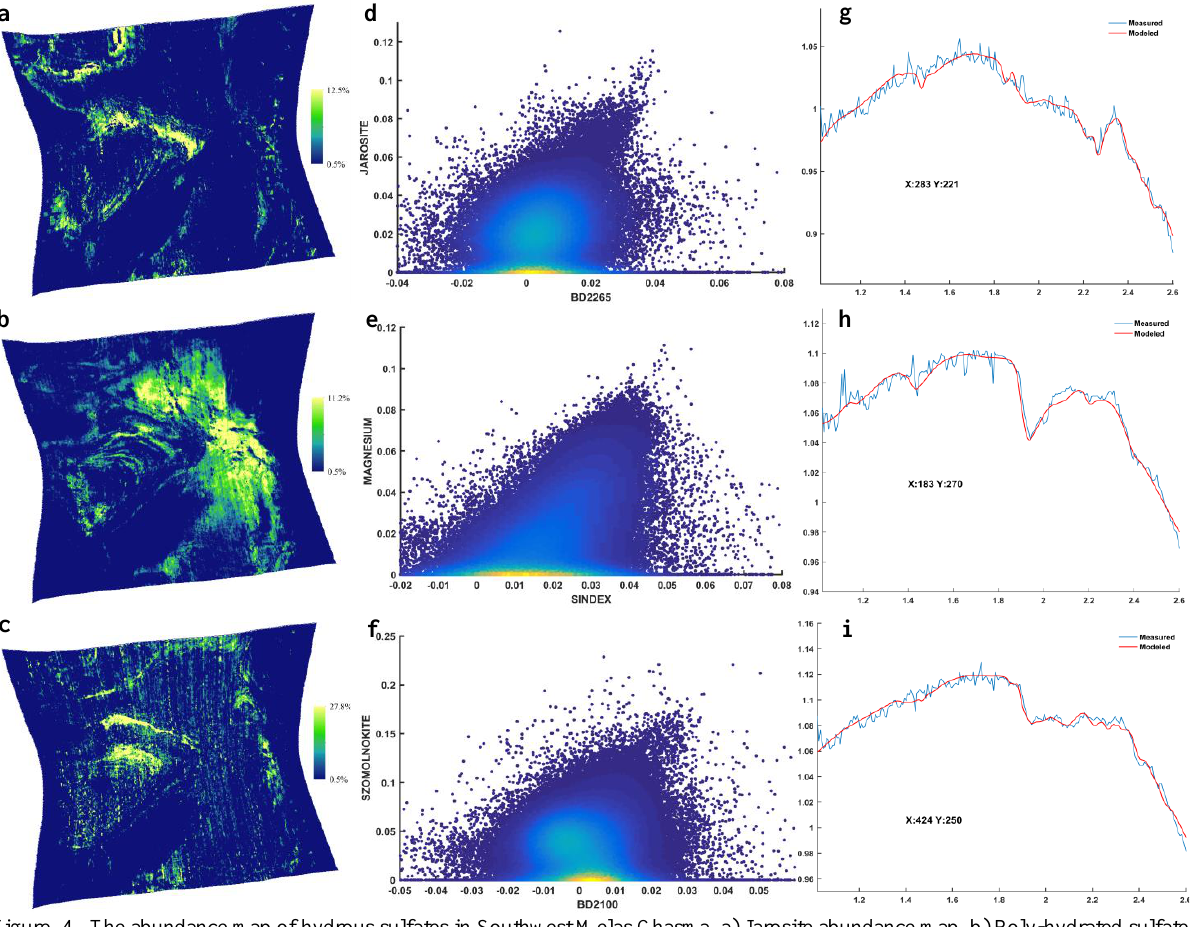
Figure. 4. The abundance map of hydrous sulfates in Southwest Melas Chasma. a) Jarosite abundance map. b) Poly-hydrated sulfate abundance. c) Szomolnokite abundance map. d) The correlation between jarosite abundance and BD2265. e) The correlation between poly-hydrated sulfate abundance and SINDEX. f) The correlation between szomolnokite abundance and BD2100. g) TTCSU fit of pixels with high abundance jarosite. h) TTCSU fit of pixels with high abundance poly-hydrated sulfate. i) TTCSU fit of pixels with high abundance